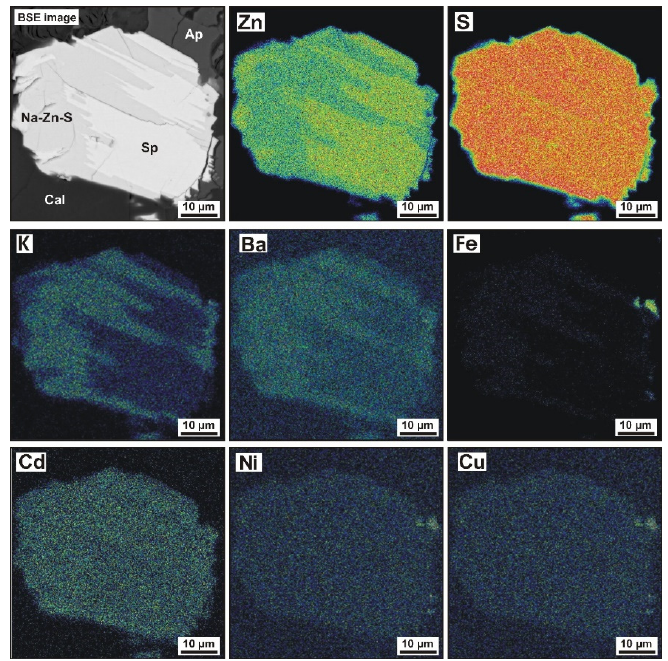
Figure 7. BSE image and elemental maps (Zn, S, K, Ba, Fe, Cd, Ni, Cu) showing intimately intergrown sphalerite and Na(K,Ba)-Zn sulfide. Sample DT-26. Ap = fluorapatite, Cal = calcite, Na-Zn-S = Na(K,Ba)-Zn sulfide, Sp = sphalerite. The Na map is not shown here due to Zn-Na overlapping.